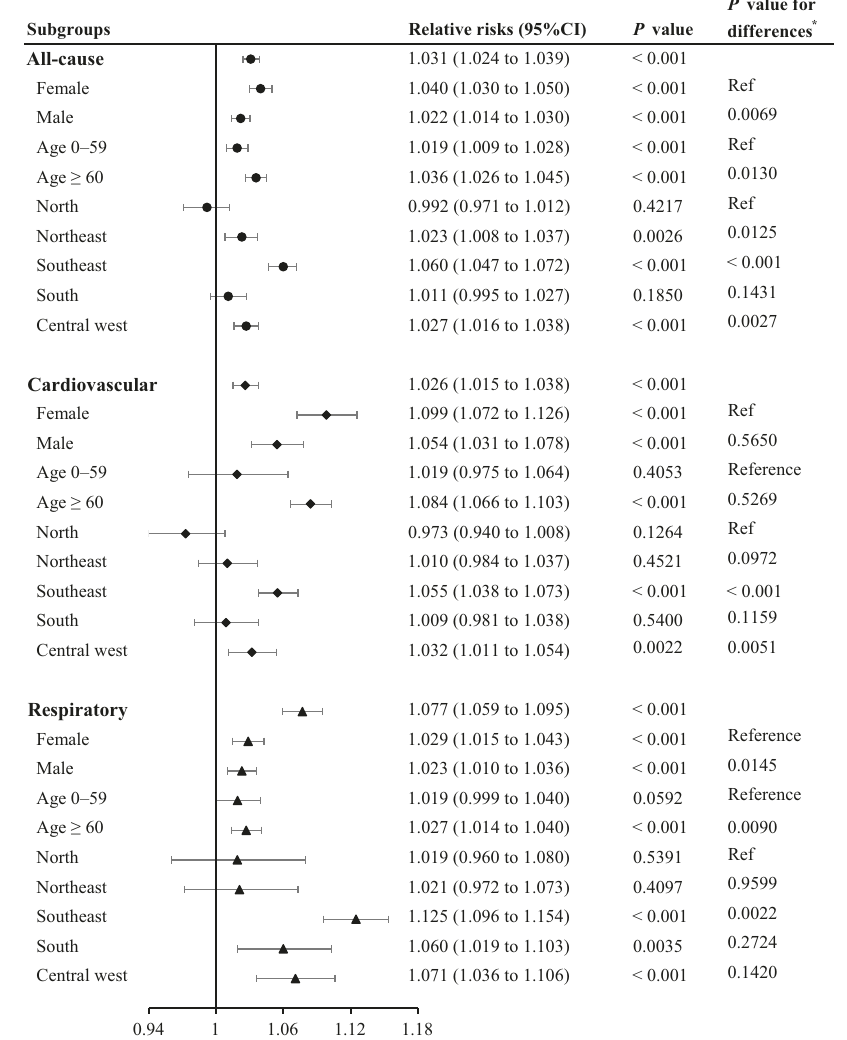
con fi denceintervals,centerfortheerrorbarscorrespondtopointsestimateofRRs. Note 3: cause-, age- and sex-speci fi c estimates were derived from the main model with data in 510 immediate regions. Estimates were pooled for each region, i.e., n =62inNorth, n =154inNortheast, n =53inCentralWest, n =145inSoutheast,and fi ne particulate matter with diameter ≤ 2.5 μ n =96 in South. Note 4: PM 2.5 ,